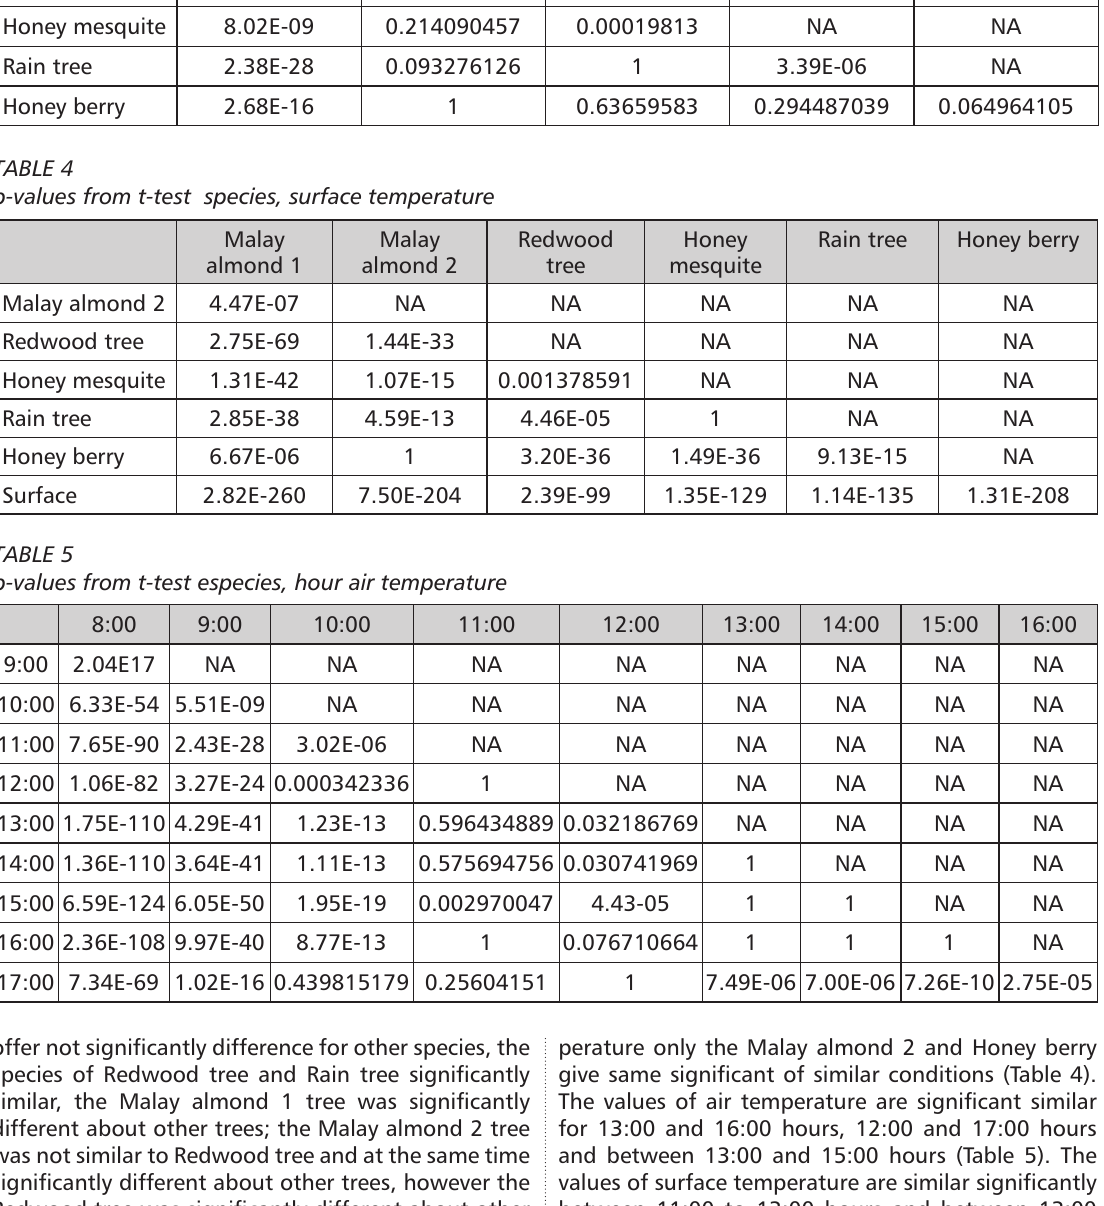
perature only the Malay almond 2 and Honey berry